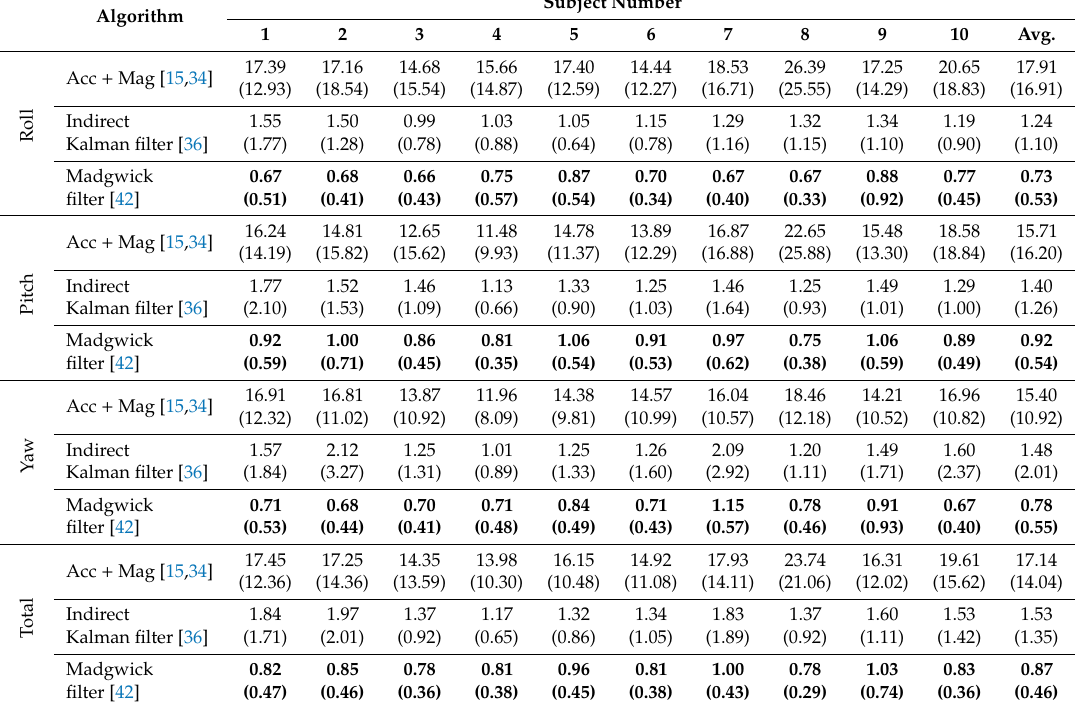
Table 4. Means (standard deviations) of the RMSEs in di ff erent methods for estimating the roll, pitch, yaw and total orientation of a cane (unit: